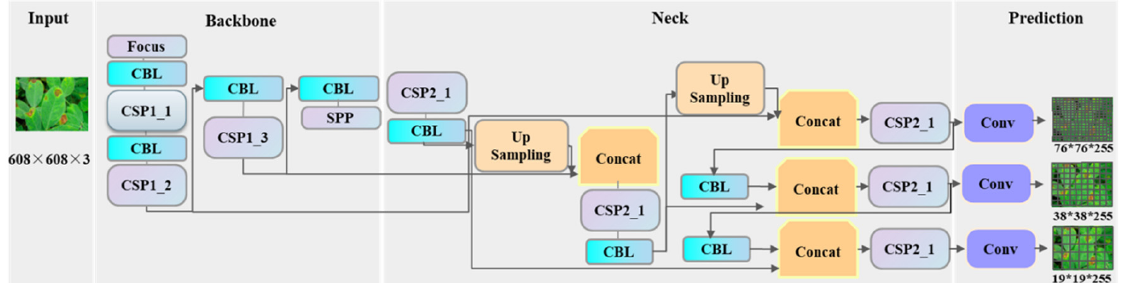
Figure 3. The structure of the YOLOv5 model (each layer and functional structure mainly include: input: mosaic data enhancement and adaptive anchor box calculation; backbone: focus structure and CSP structure; neck: FPN + PAN structure; prediction: